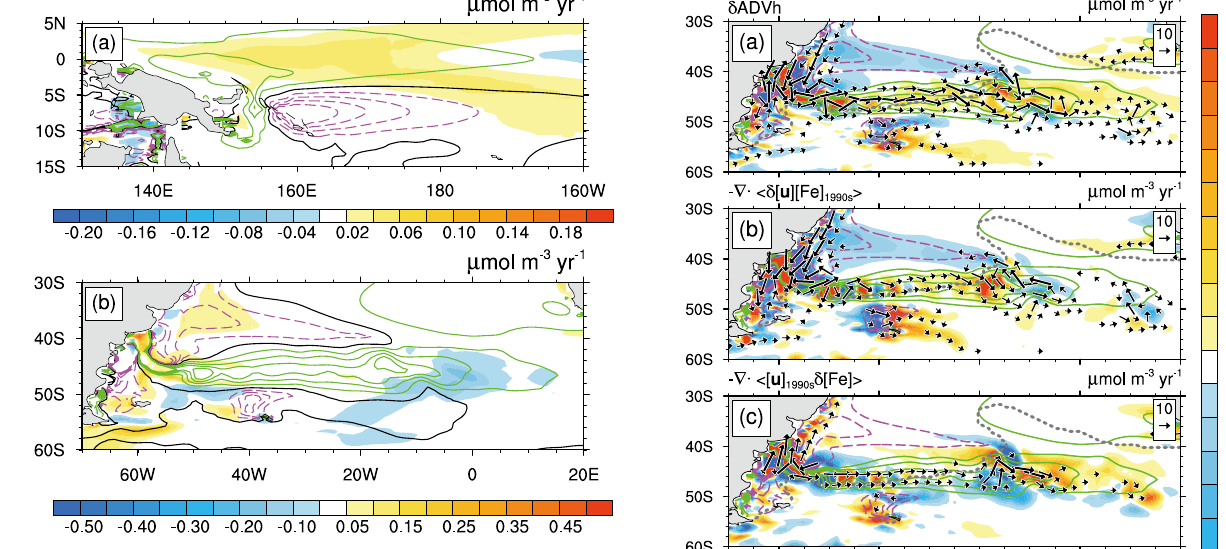
Fig. 14. Spatial distribution of the diagnosed annual mean dissolved iron tendency (color scale, µmolm − 3 yr − 1 ) averaged over the up- per 300m attributed to changes in the biological production (i.e., excluding the influence of iron scavenging from Fig. 9d) (a) . The same as (a) , but averaged over the upper 100m (b) . Contour lines are the same as in Fig. 9b, except that the interval in (b) is 0.05nM and contours with an absolute value exceeding 0.2nM are omitted.